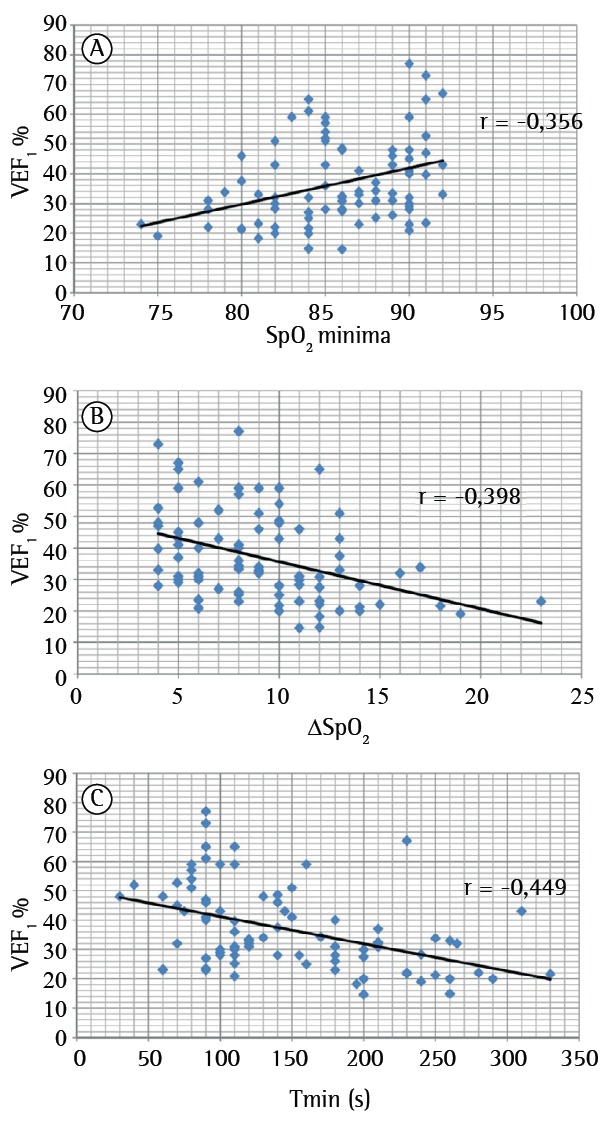
 Correlações das variações do VEF1% com a SpO2 mínima (em A), com ΔSpO2
(em B) e com o tempo para atingir SpO2 mínima (Tmin; em C)